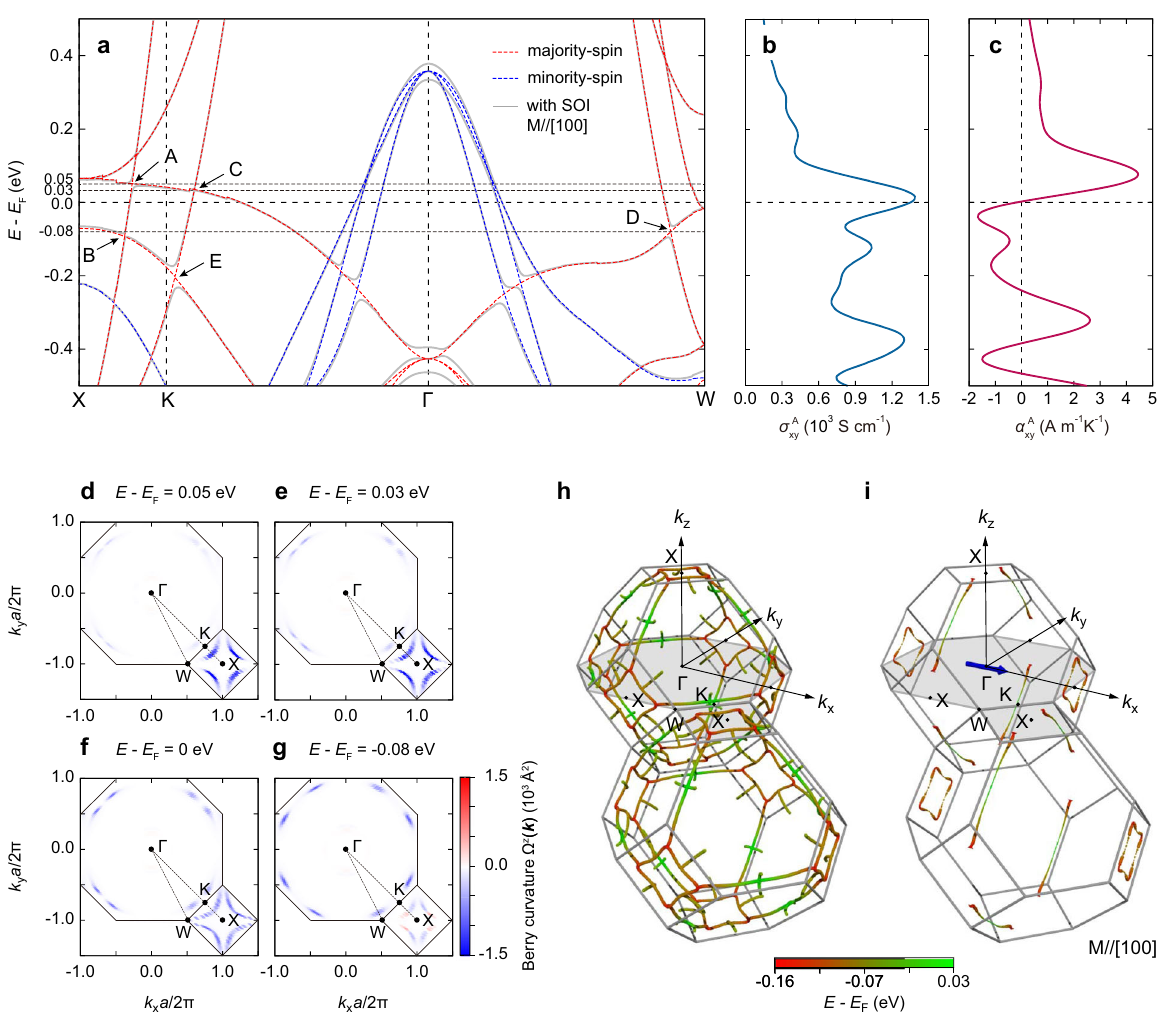
Fig. 2 Calculated band structure, Berry curvature, and anomalous Hall and Nernst conductivities of Co 2 MnGa. a Band structures and calculated, b σ A xy , and c α A xy of L 2 1 -ordered Co 2 MnGa. d − g Berry curvatures Ω z ( k ) calculated at E − E F = 0.05, 0.03, 0, and − 0.08 eV, respectively. h Three-dimensional view of the Weyl nodal lines in the fi rst and second Brillouin zones of Co 2 MnGa, where the k z = 0 and k z = 2 π / a planes are highlighted, in the absence of SOI. Color corresponds to the location of the Weyl node. i Same as h but with SOI and magnetization along [100]. The blue arrow indicates the direction of